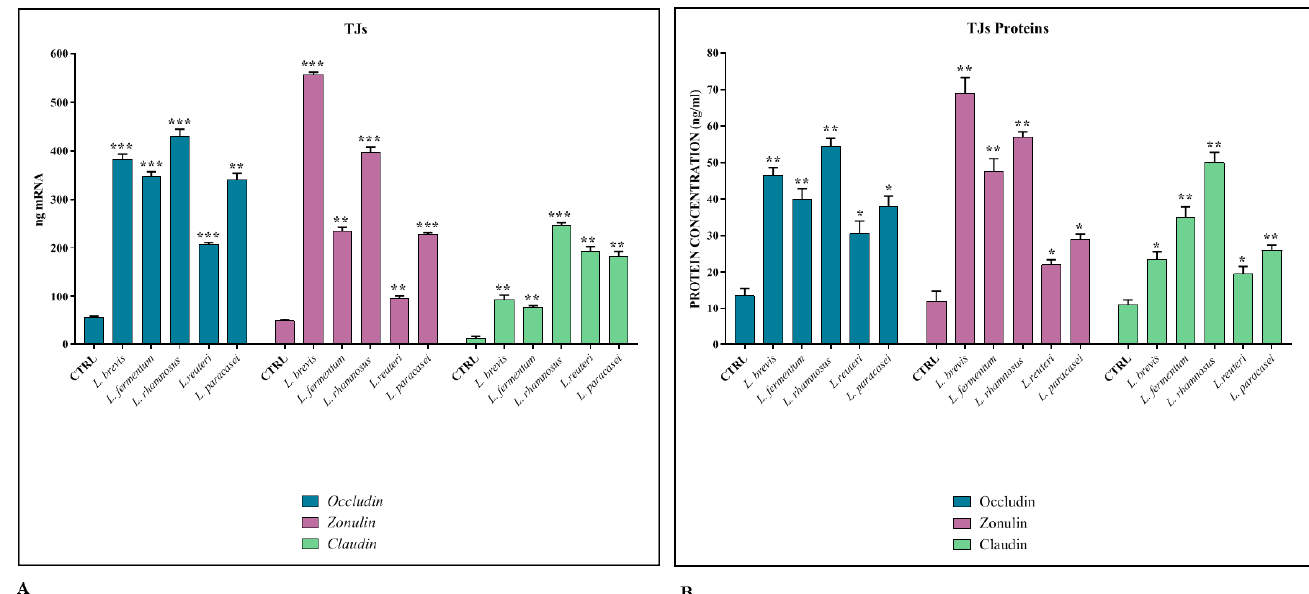
Figure 1. TJ expression. Comparison between relative gene expression ( A ) and protein concentration ( B ) in Caco-2-HT29-MTX co-cultures treated with different strains of Lactobacillus spp. The data are representative of three di ff erent experiments ± SD. Signi fi cant di ff erences are indicated by * p < 0.05, ** p < 0.01, *** p < 0.001.